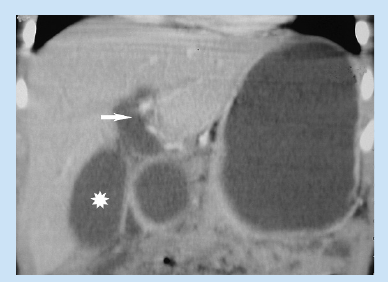
Fig.2b. Coronal reconstructions confirm the well-marginated pancreatic cyst separated from the dilated common duct (arrow) and gallbladder